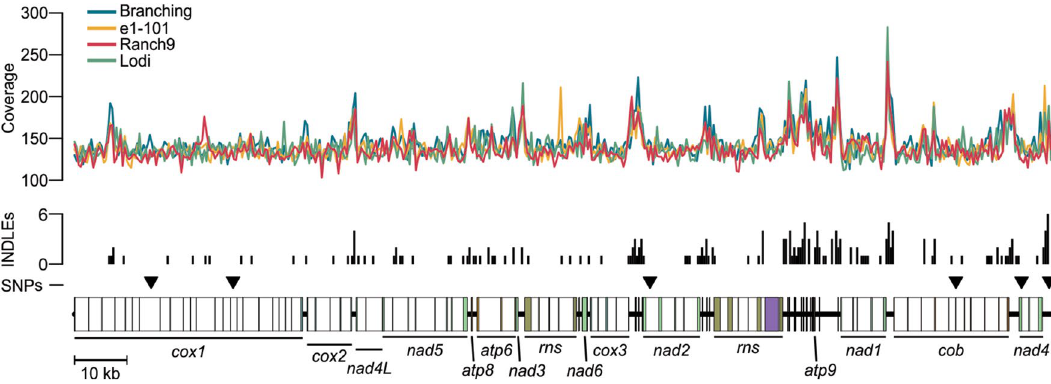
Figure 3. Comparative analysis of the mitochondrial (mt) genomes of five isolates of E. necator shows no presence/absence of introns and low genetic variability within functional regions. Whole-genome sequencing (WGS) coverage of four E. necator isolates across the reference mt genome of isolate C-strain is shown at the top. The histogram shows the number of insertions or deletions (INDELs) identified in different regions of the mt genome. Location of identified single nucleotide polymorphisms (SNPs) are indicated with triangles (total of six). The WGS coverage suggests that all regions of the reference mt genome are conserved in the other four isolates analyzed. Low number of SNPs and presence of almost all INDELs within intergenic or intronic regions indicate low genetic variability within functional regions of the mt genome of E. necator . Coverage of WGS reads and the INDEL histogram were generated with a non-overlapping sliding window of 400 bp. Coverage of WGS reads was normalized to 100 × prior alignment. The figure was generated with R v4.0.3 (https:// www.r- proje ct. org) and further edited with Inkscape v1.0.2 (https:// inksc ape.